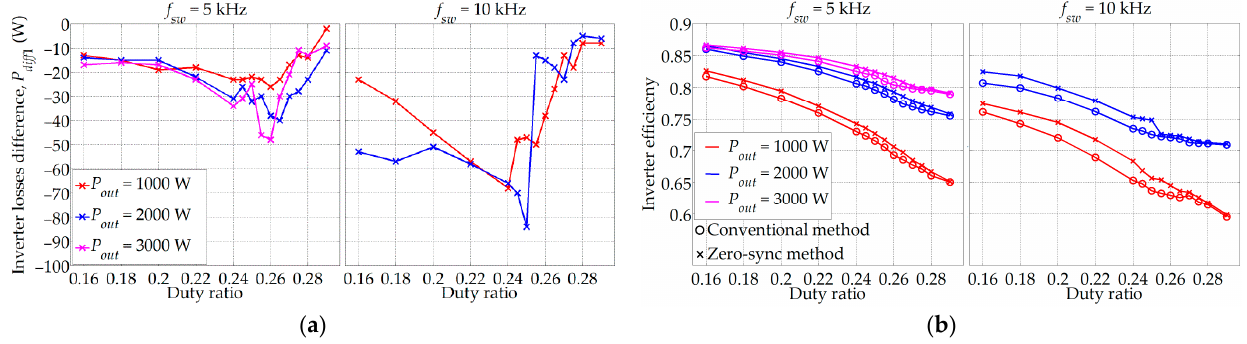
Figure 12. Inverter losses difference ( P diff 1 ) ( a ) and inverter efficiency ( b ) as a function of the duty ratio for different values of the load power and switching frequency.